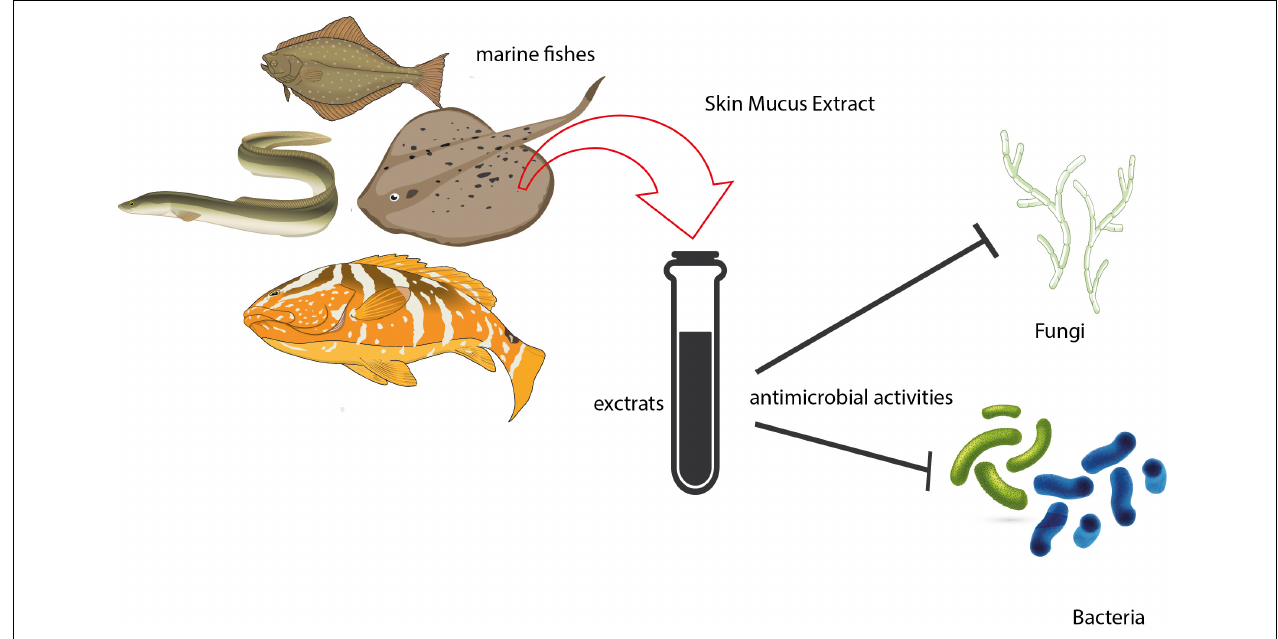
FIGURE 1 | Antimicrobial properties of skin mucus in marine teleosts and elasmobranchs.